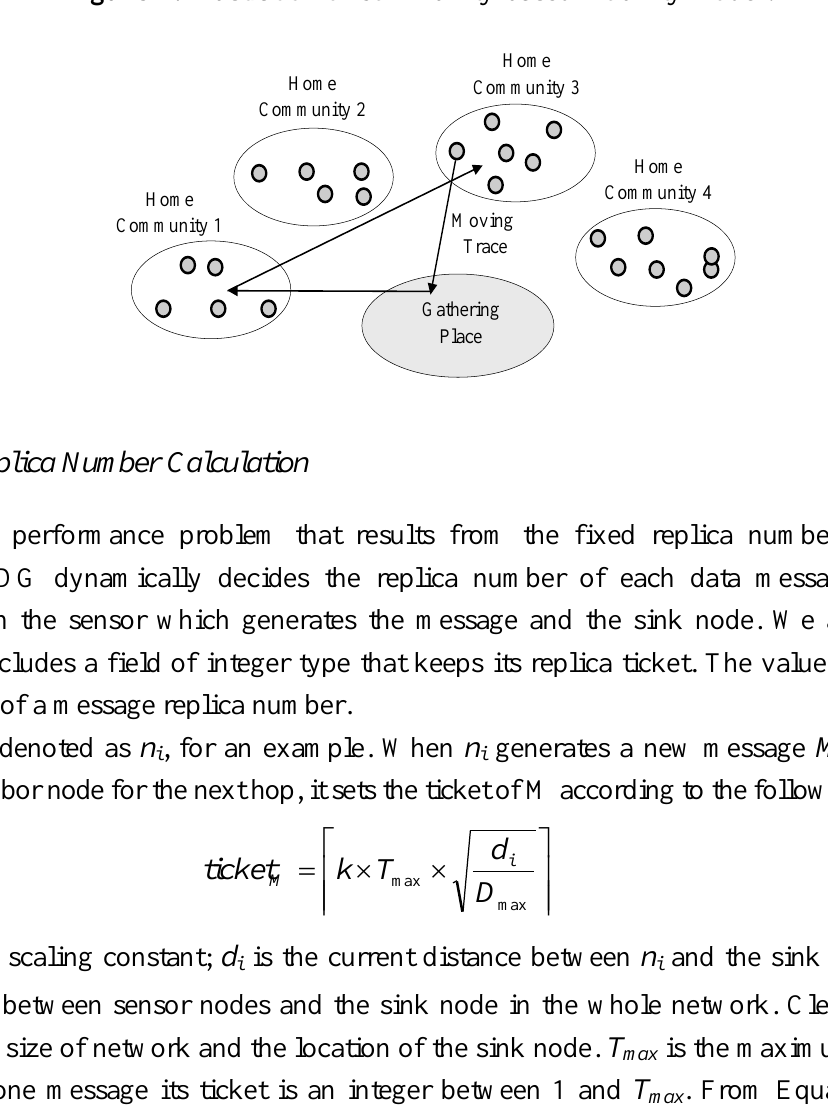
Figure 1. Illustration of community-based mobility